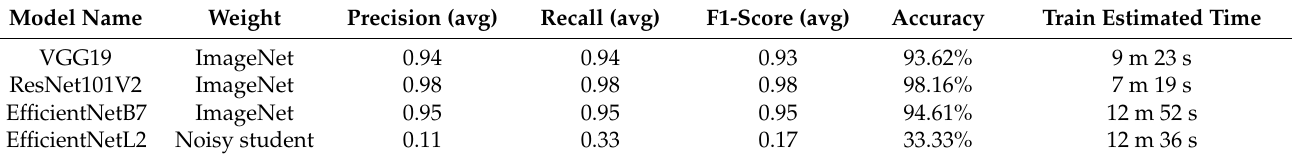
Table 2. Performance evaluation of the independent models.